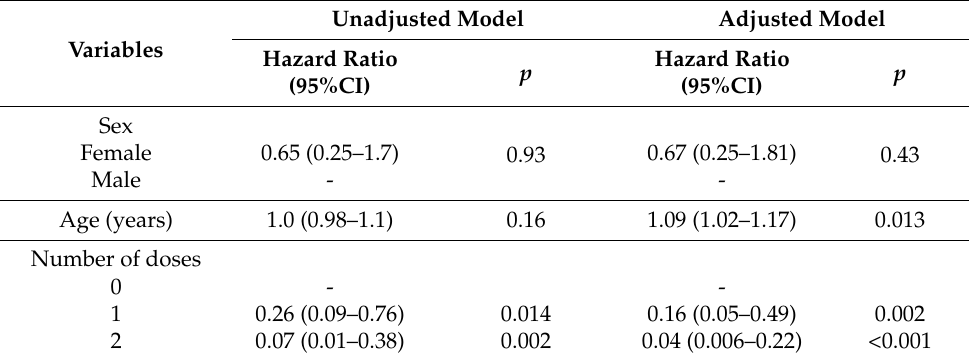
Table 2. Cox proportional hazards regression analysis of variables associated with COVID-19 related mortality in 100 SARS-CoV-2+